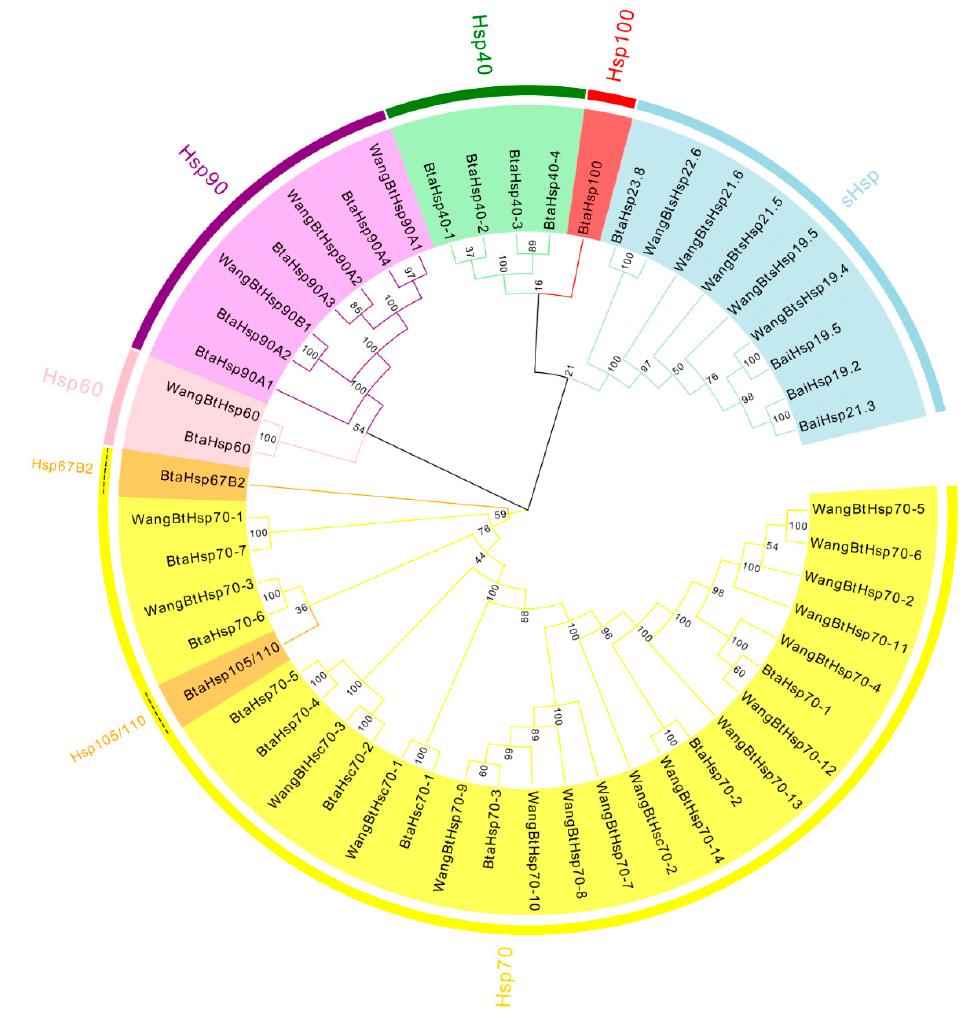
Figure 4. Phylogenetic relationships of 29 BtHsp of Bemisia tabaci (Wang et al., 2019; Bai et al., 2019) and 22 BtaHsp s of this study. The unrooted phylogenetic tree was constructed using MEGA7 by the neighbor − joining method and the bootstrap test was set as 1000 replicates. The colored shadow represents the different BtaHsp families.